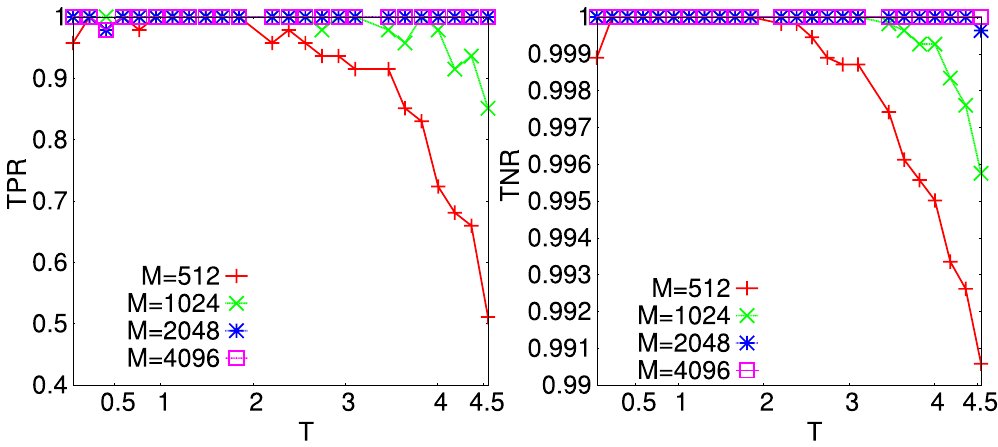
Figure 3. TPR (Left) and TNR (Right) for decimated networks at the maximum x M of the tilted pseudolikelihood  vs T at different data-set sizes M for the 4 XY model on sparse Mode-Locked graphs with t N = 16, N q = 47, .  T N ( ) 0 50 ( T c ( ∞ ) = 0). c